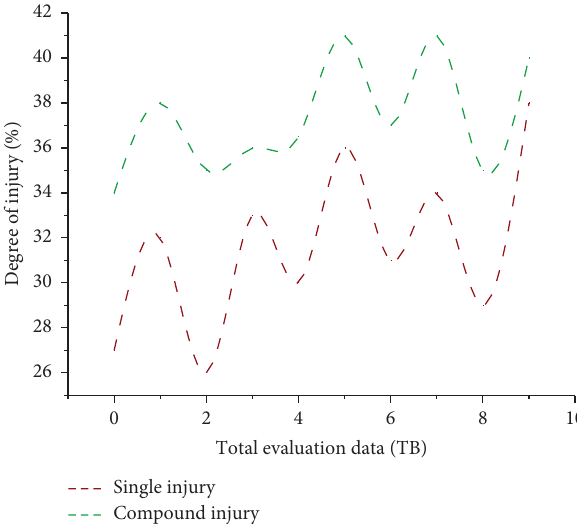
Figure 9: Comparison chart of damage